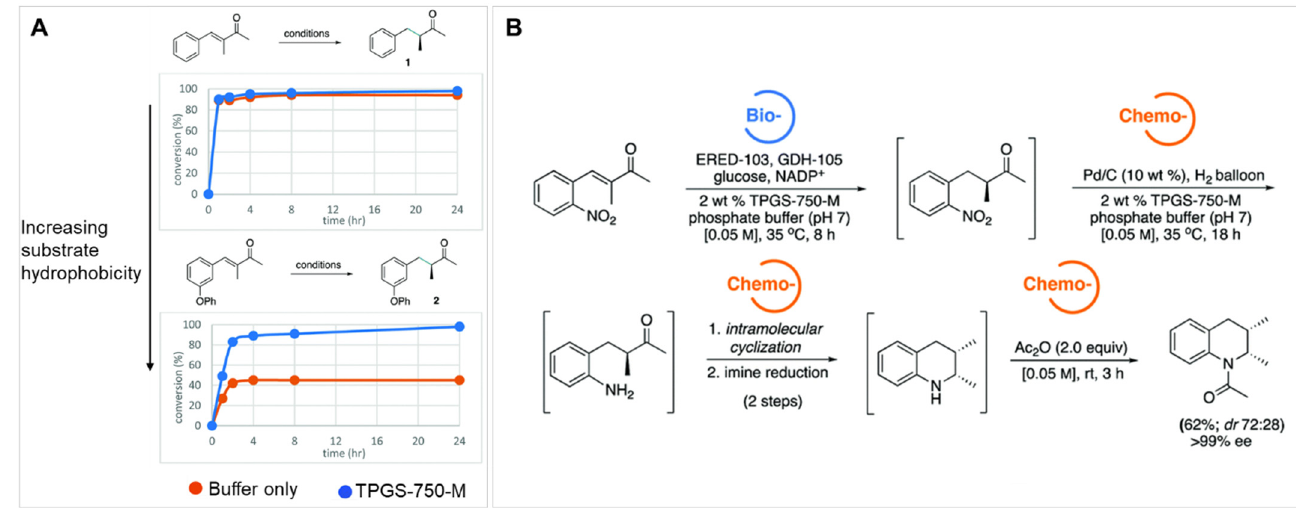
Figure 13. ( A ) Enone reductions with and without surfactant. Catalytic performance of the enzyme was not significantly affected by the presence of the surfactant, as evidenced by both the rate and the extent of conversion to product 1. However, reactions using substrates with increasing lipophilicity were affected by the surfactant. For product 2, conversion did not exceed 45% in phosphate buffer alone (0.1 M) at pH = 7. The addition of TPGS-750-M increased the conversion to 100% within the same 24 h time period. ( B ) Tandem four-step, one-pot process in TPGS-750-M micelles involving enzymatic enone reduction, nitro-group reduction, intramolecular cyclization/imine reduction, and acylation. The final product was isolated by extraction with 62% isolated yield. Adapted from [152] with permission.